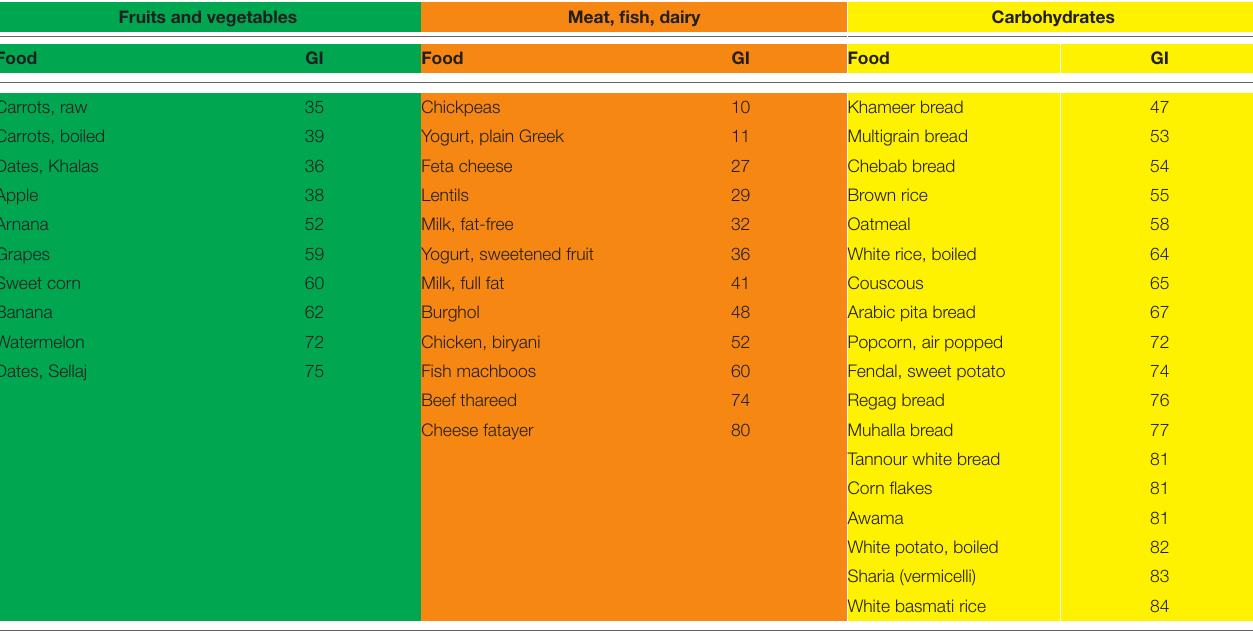
TABLE 4 | Glycemic index (GI) values of some common Middle Eastern foods by food group*. Fruits and vegetables Meat, fish, dairy Food